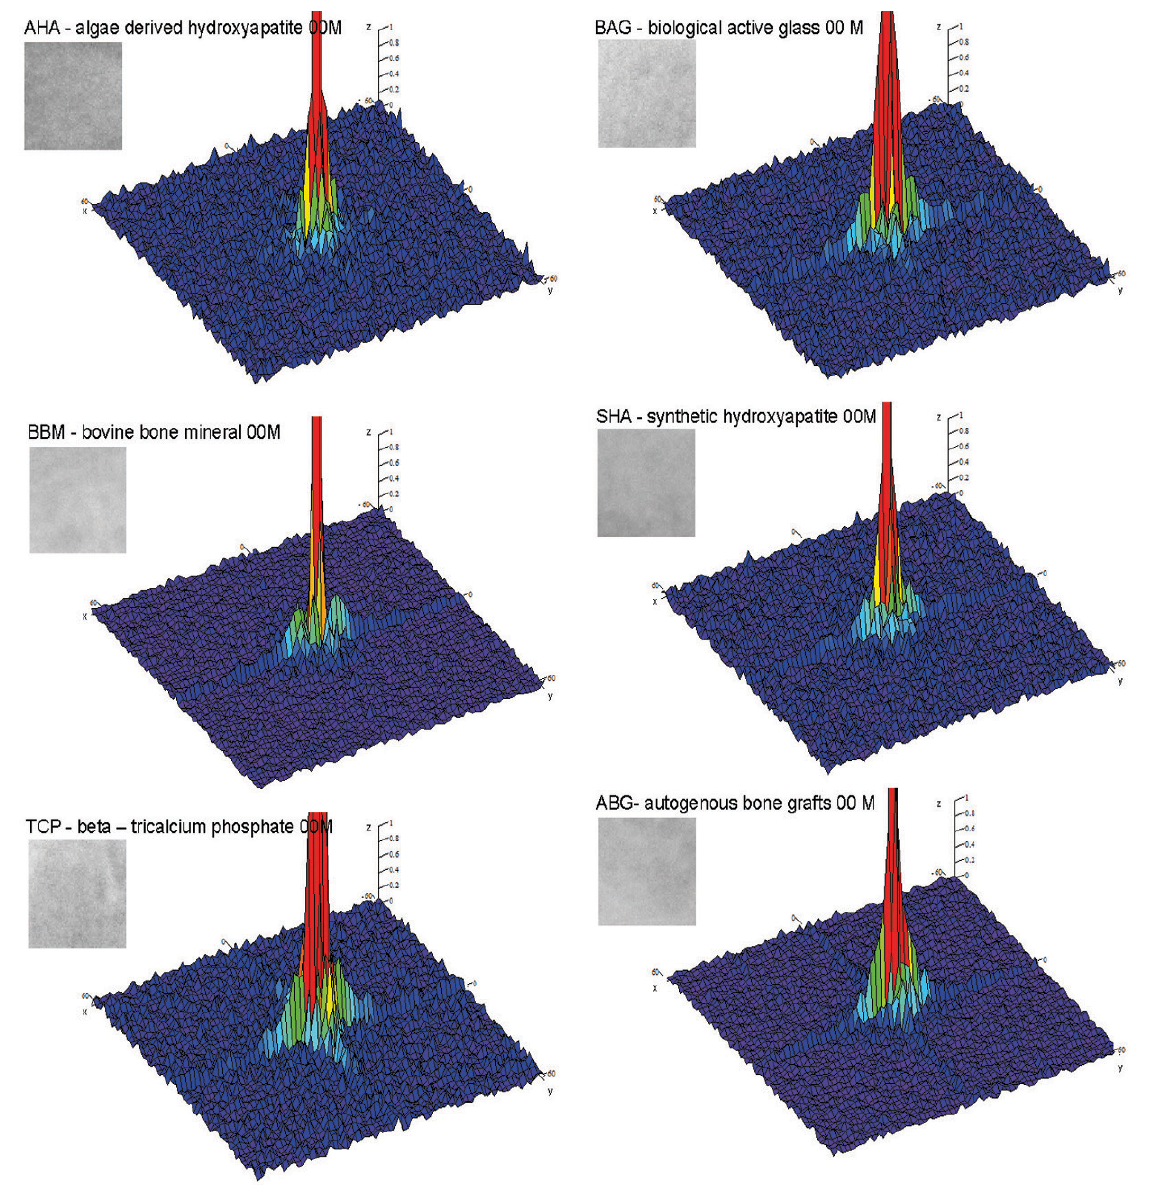
Figure 1a. Results of Fourier Transformation: 3 dimension presentation of amplitude distributions the Fourier Transformation of analysed images; (axes: x,y – spatial frequencies, z – amplitude). Abbreviation: 00M – state immediately after